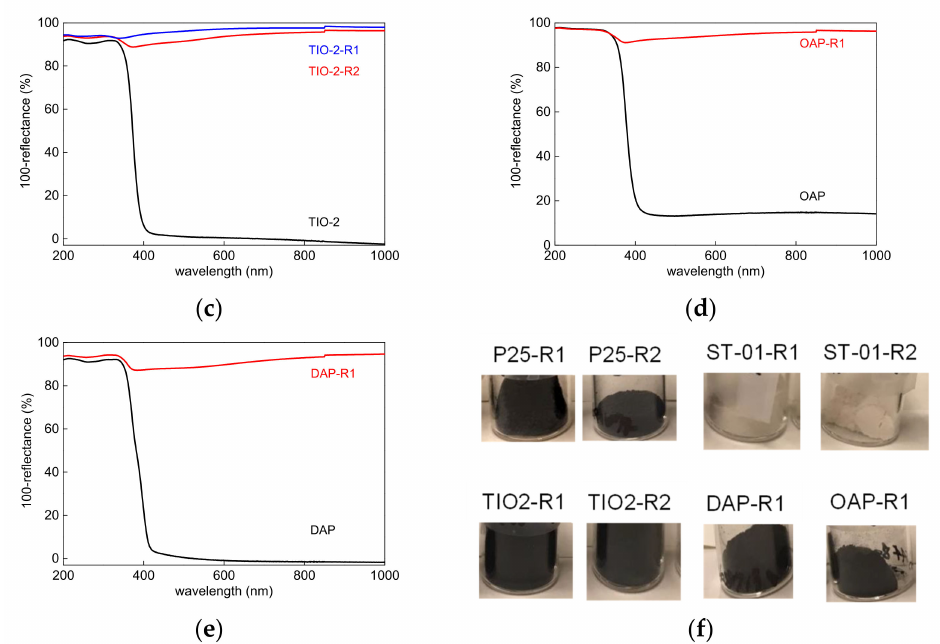
Figure 1. ( a – e ) DRS properties of pristine and reduced titania: ( a ) P25; ( b ) ST01; ( c ) TIO-2; ( d ) OAP; ( e ) DAP; and ( f ) the photographs of the hydrogenated titania